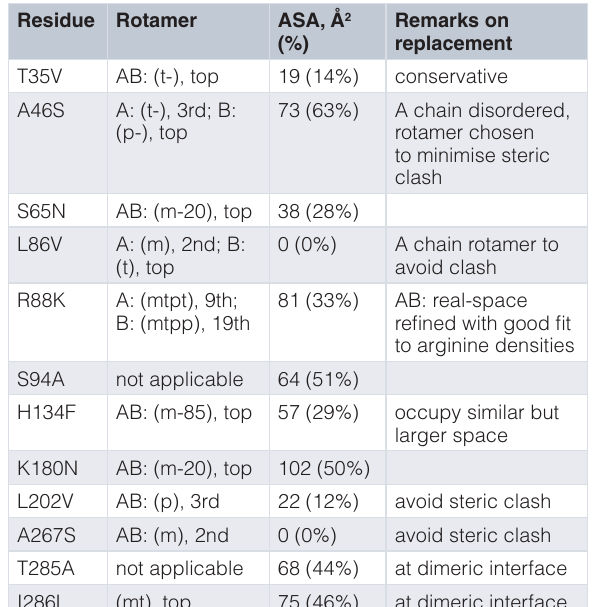
Table 2. In silico mutagenesis to make the SARS-CoV-2 3CL pro . The 12 variant residues with reference to the SARS-CoV enzyme are shown with the respective treatment of rotamer. “A” and “B” refers to the individual chains of the dimeric model. Both chains are in the crystal asymmetric unit and are not identical. The rotamer symbol (bracketed) is defined according to the conventions of Richardson 13 , followed by its respective rank of popularity. ‘ASA’: accessible surface area (average of A and B chains) of the residue in the SARS-CoV 3CL pro structure, in Å 2 and in % relative to the ASA of a residue X in the Gly-X-Gly conformation.